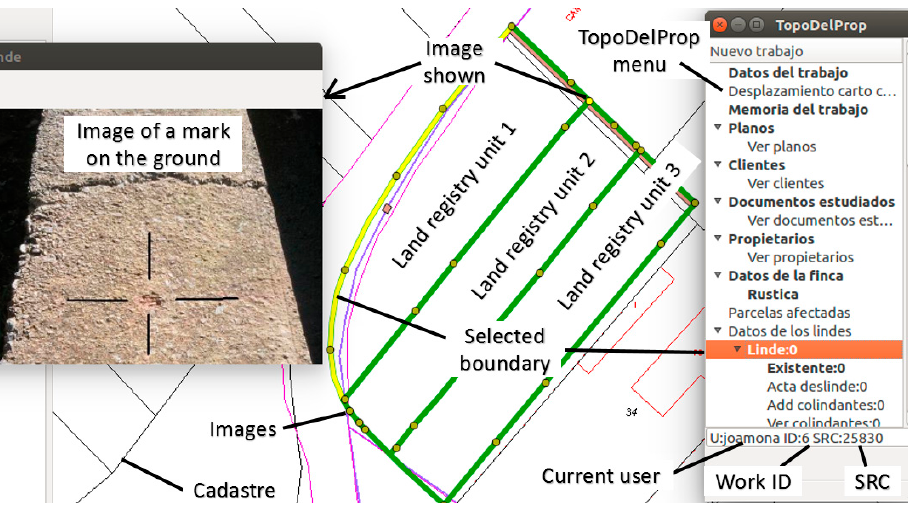
Figure 6. Three land registry units within the same cadastral parcel. Source: own elaboration.